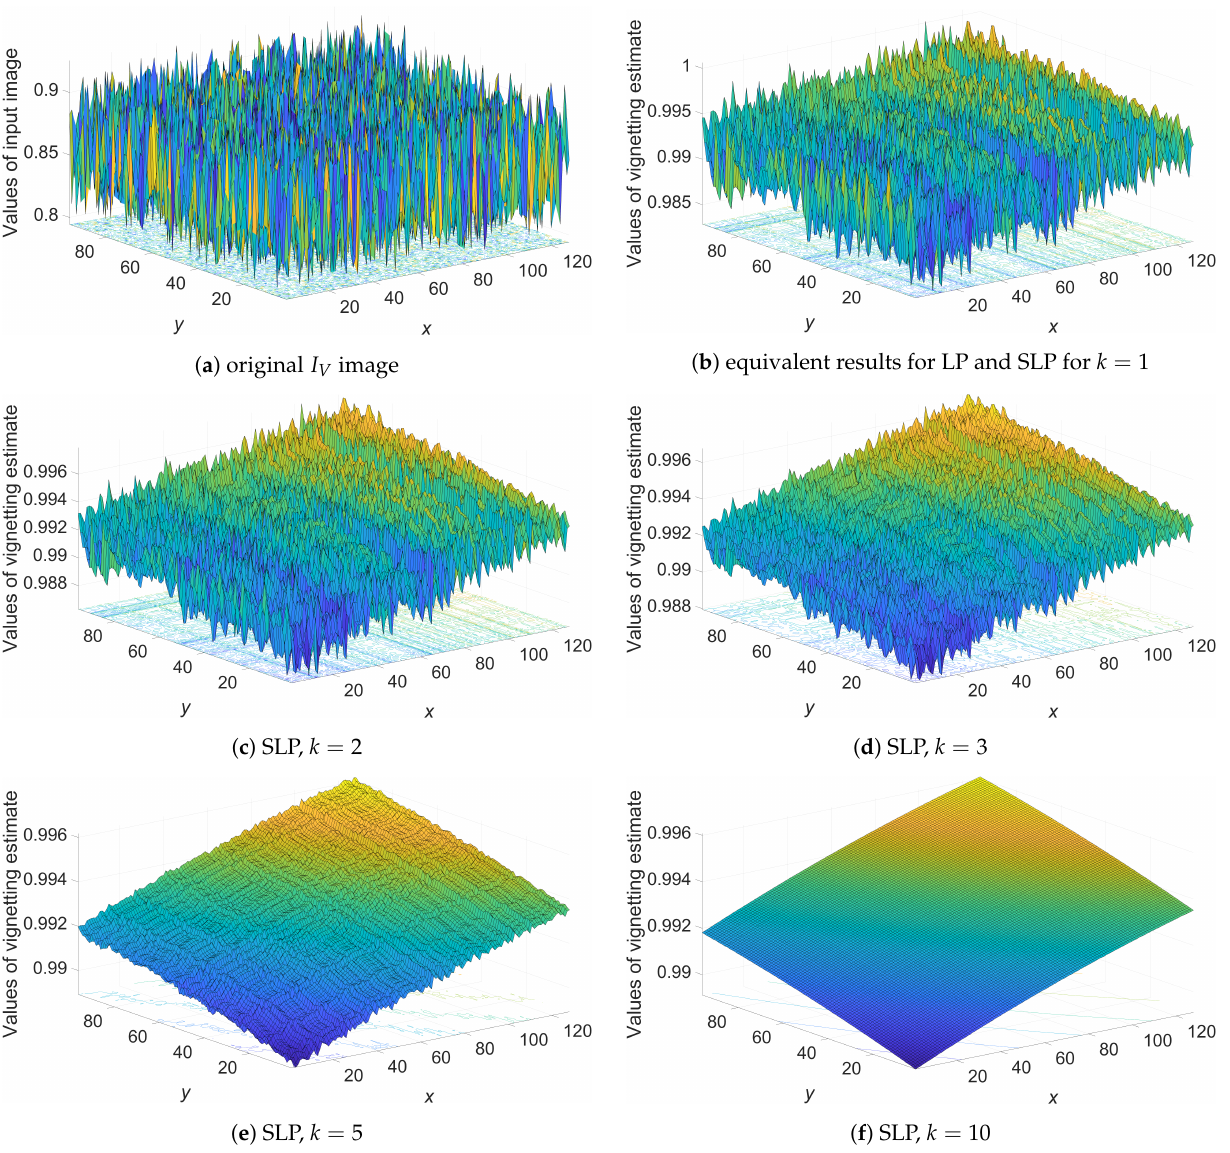
Figure 2. Comparison of surface smoothness of vignetting estimators (cid:101) V obtained from: ( b ) LP and ( b – f ) SLP models, ( a ) image I V of size 640 × 480 pixels contained with Gaussian mixture noise (A5) for σ add = 5% and σ multi =